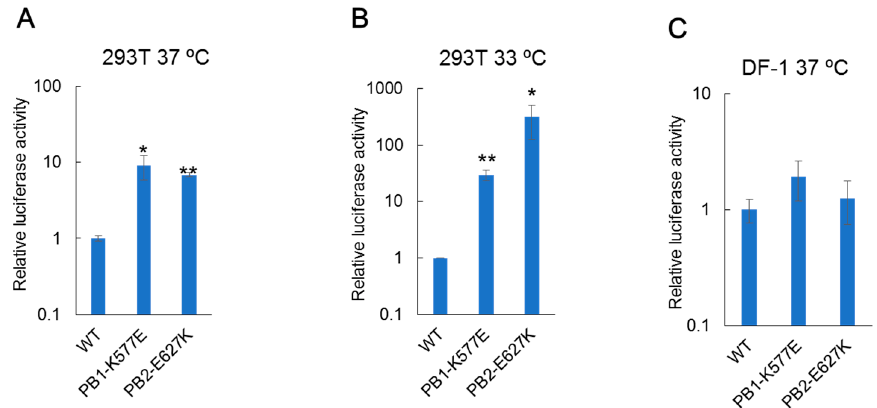
Figure 3. Polymerase activity of PB1-K577E. Polymerase activity was analyzed by a luciferase reporter assay. A plasmid expressing PB1-K577E or PB2-E627K was cotransfected into human 293T or chicken DF-1 cells with four plasmids expressing WT-PB2 (or -PB1), -PA, and -NP plus a reporter plasmid